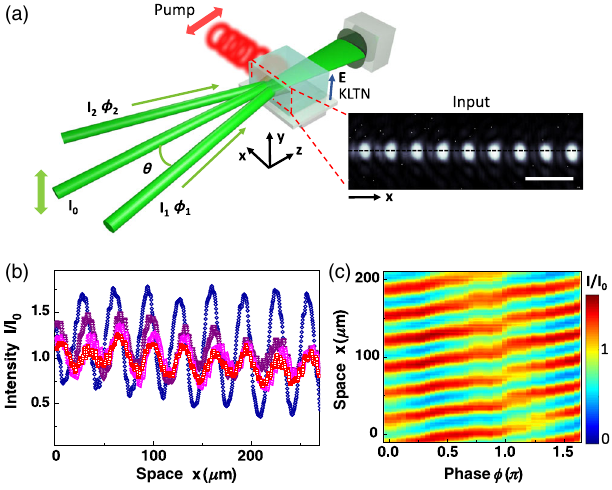
FIG. 1. Experimental setup. (a) Sketch for the symmetric three- wave interferometric scheme used to generate a quasi-one- dimensional background wave with a single-mode perturbation that propagates in a pumped photorefractive KLTN crystal (see the Appendix). The inset shows an example of the detected input intensity distribution (scale bar is 50 μ m). (b) Input intensity x profiles normalized to the background for different amplitudes of the harmonic perturbation ( k ¼ 0 . 019 μ m − 1 ). (c) Phase control of the initial condition: intensity distribution varying the relative phase ϕ between the interfering